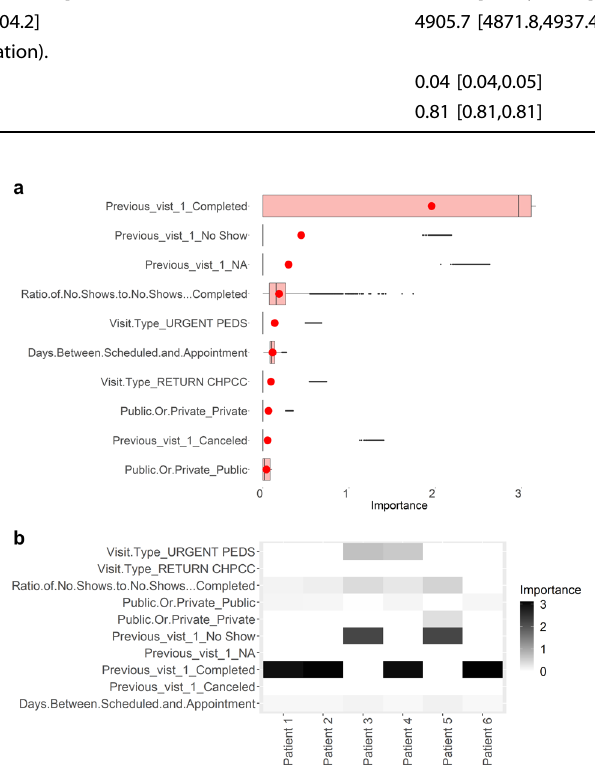
Fig. 2 Feature importance in predicting no-shows. a Importance of each feature in predicting no-shows, where the top 10 features are shown. The red circle is the mean value of each group. In all boxplots in this study, centreline represents median, bounds of box represent fi rst and third quantiles, and whiskers represent minimum and maximum values excluding outliers. b Examples of the importance of each feature in predicting no-shows in different visits of patients. Examples of six visits are